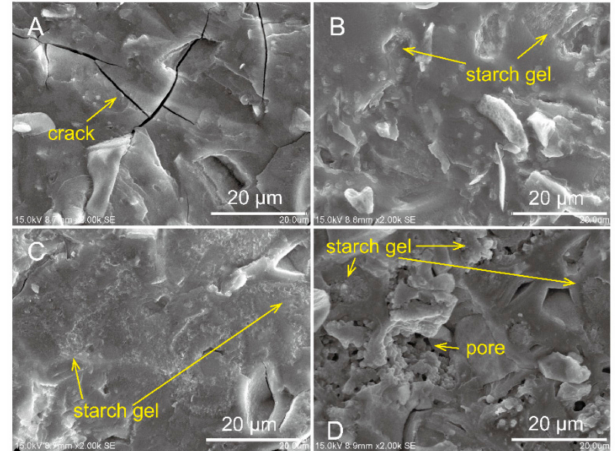
Figure 9. SEM image of AAM paste with various composition of CMS, A sample 1#, B sample 2#, C sample 3# and D sample